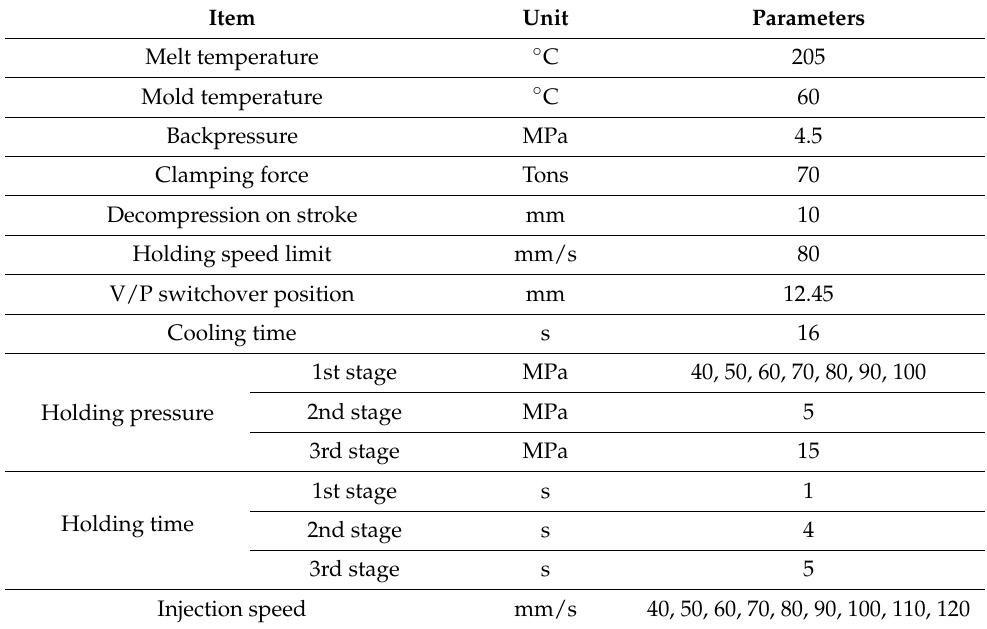
Table 1. Injection molding process